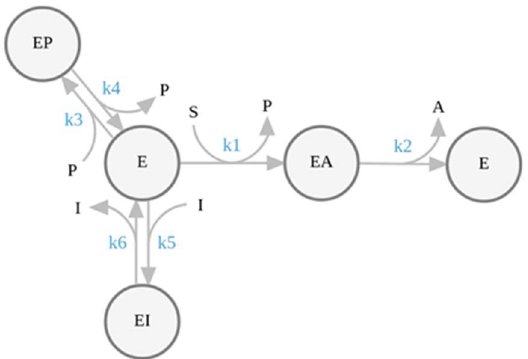
Figure 5. Mechanims of AChE inhibition by GAL. The hydrolysis of ACh (S) by AChE is a two-step reaction. The first step lead to the release of choline (P) and formation of the acylated enzyme (EA). In the second step the acyl-enzyme is resolved with release of acetate (A) and formation of free enzyme (E). P rapidly reacts stechiometrically with the Ellman’s reagent to form thiocholine-TNB (the detected specie), which competitively inhibits AChE. I is the inhibitor (galantamine). k 1 is an apparent bimolecular constant rate equivalent to k cat / K m and k 2 is the catalytic constant. k 3 and k 4 are the binding and the dissociation rate constants for the formation of the EP complex. k 5 and k 6 are the microscopic rate constants for the binding ( k on ) and the dissociation ( k off ) of GAL to the AChE active site.